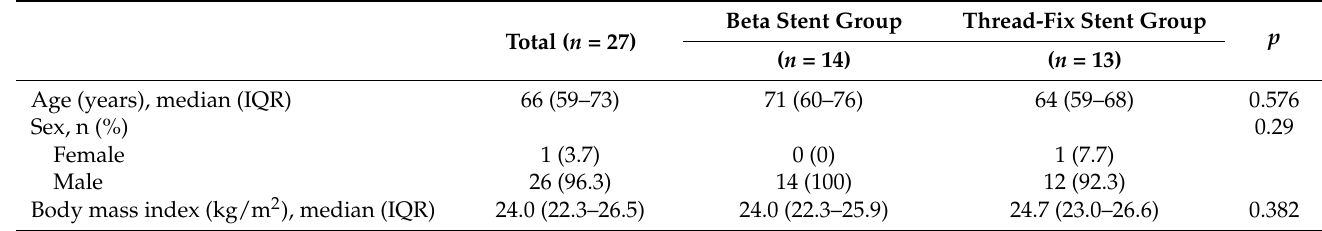
Table 1. Baseline patient characteristics.